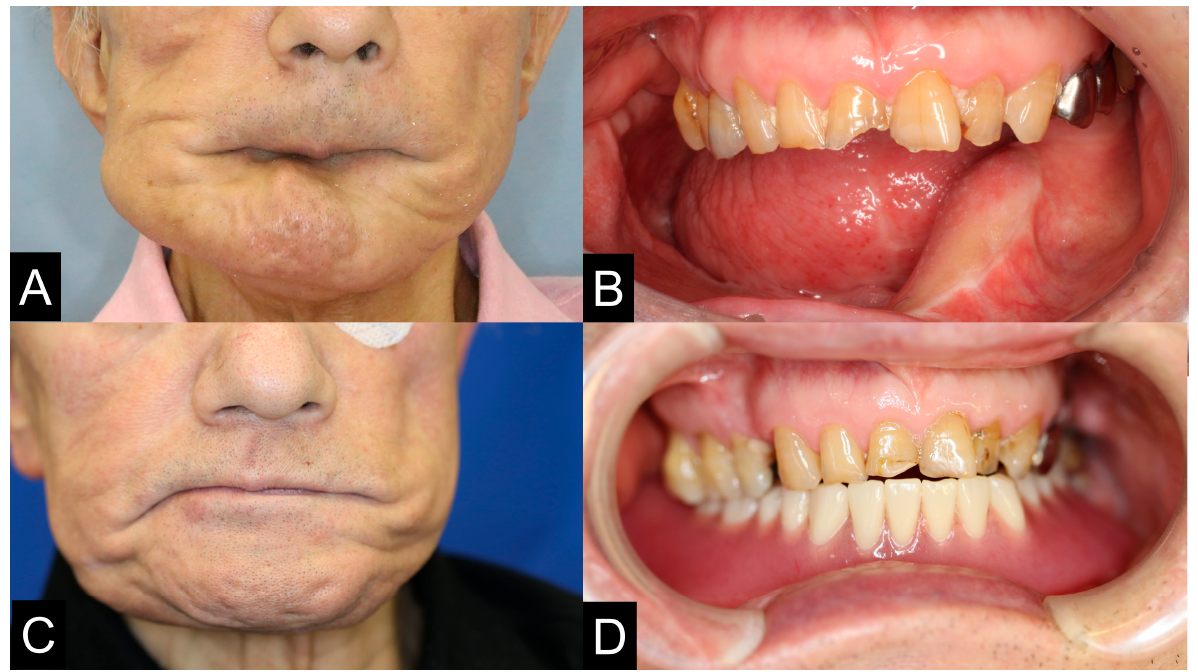
Figure 12. The surgical plate was removed and his pre-bended custom-made TiMesh was fixed with a positioning device and a PCBM was grafted. After the operation, the mandibular deviation has corrected and the position of the condyle was improved and the facial contour was significantly improved ( A , C ). Furthermore, the conventional denture could then be fitted in the mandible ( B , D ).